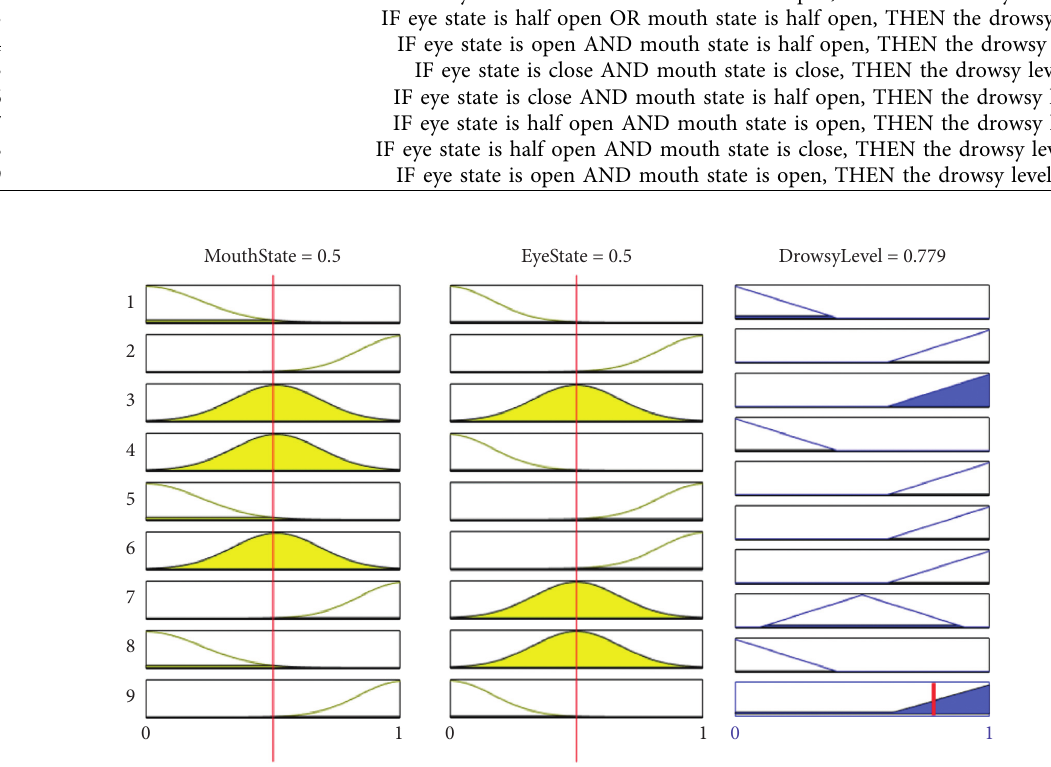
Figure 11: Rule’s